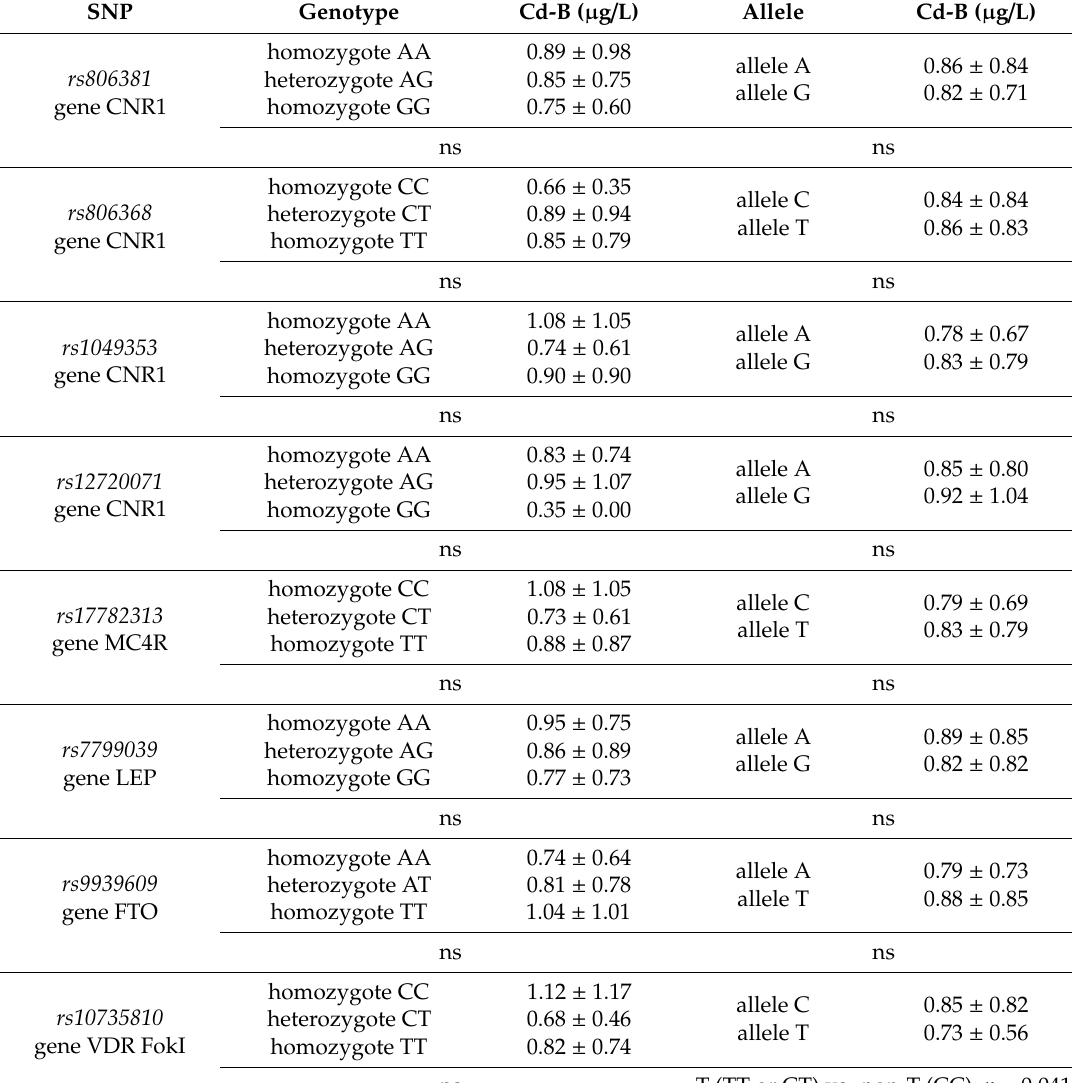
Table 6. Cadmium concentration in subgroups divided according to selected polymorphisms of genes CNR1, MC4R, LEP, FTO and VDR